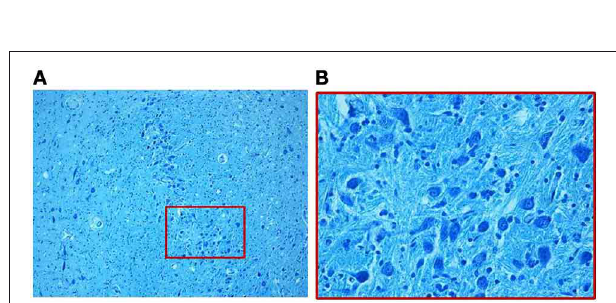
FIGURE 6 | Dense population of prevalently immature neurons with limited dendritic arbor, as better shown in the boxed area of (A) at greater magnification in (B), in a SIDS case 3-month-old. Klüver–Barrera stain. Magnification: (A) 10 × ; (B) 40 × .